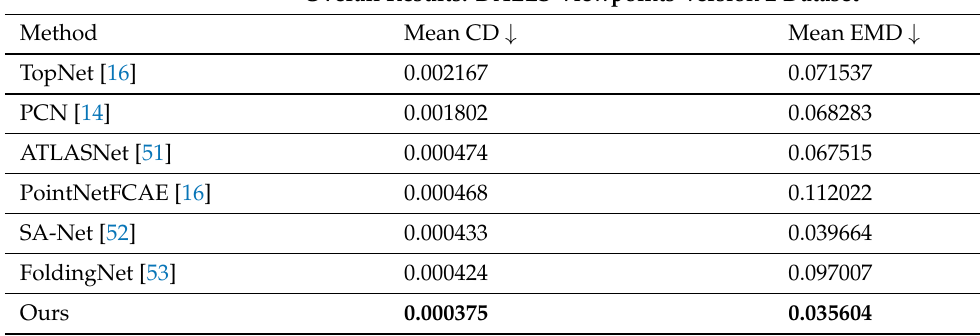
Table 1. Overall results comparing our method to current state-of-the-art point cloud completion methods on the DALES Viewpoints Version 2 dataset.